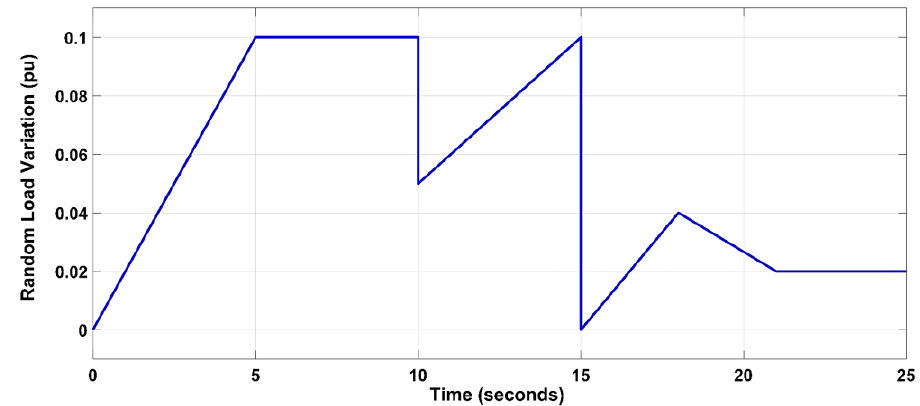
Figure 22. Random load variation.